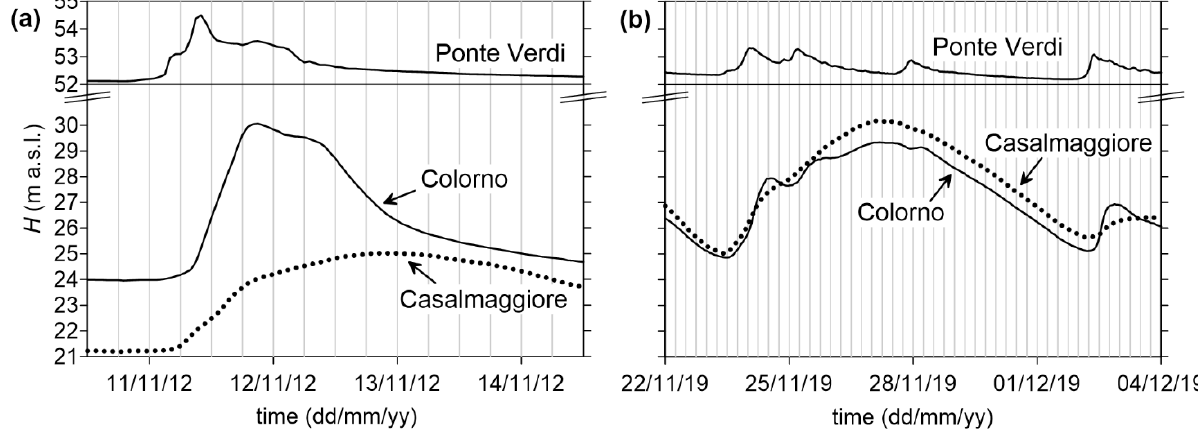
Figure 2. Qualitative examples of types of flood events in Colorno: ( a ) Parma River flood; ( b ) Po River flood.